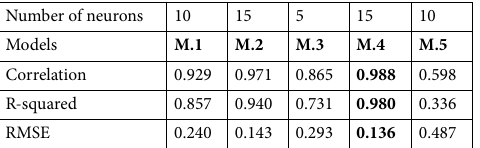
Table 3. Performance of each developed model based on the optimum number of neurons. Significant values are in bold.